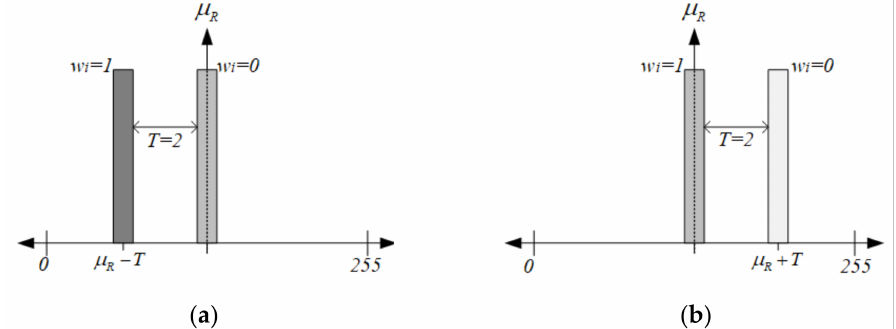
Figure 4. Histogram of the watermarked region. ( a ) Histogram of the watermarked region by Equation (2), ( b ) histogram of the watermarked region by Equation (3).